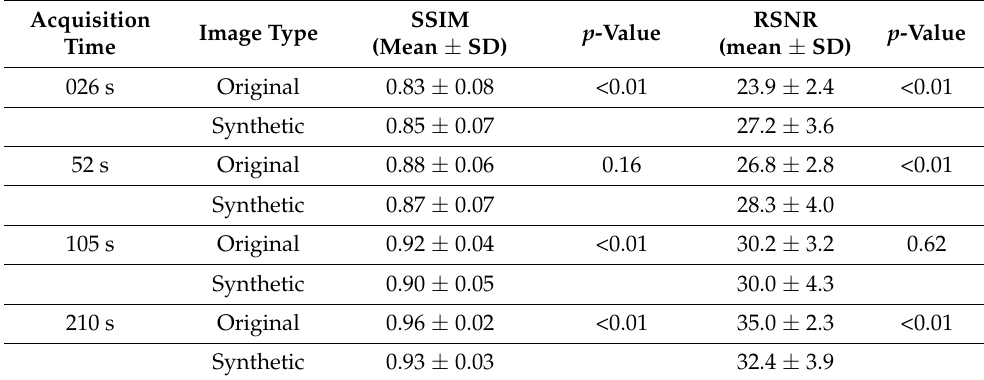
Figure 4. Quantitative analysis of the synthetic and original images. The two readers visually evaluated the degree of noise, anatomical clarity, and overall image quality of the synthetic images. The average score for all factors was >3, suggesting that the synthetic images had better image quality than the original images with shorter acquisition times. In addition, synthetic images generated from images with shorter acquisition times had higher average scores, suggesting that our image synthesis model is more effective for lower quality images with shorter acquisition times. Table 2. Quantitative analysis of the synthetic and original